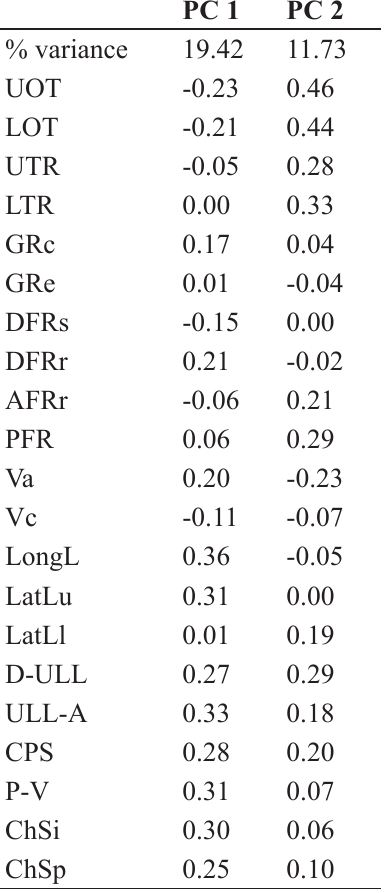
Table S7. PCA loadings of 21 counts from: H . latifrons sp. nov., H . mentatus , H . rex sp. nov., H . simba sp. nov., H . glaucus sp. nov., H . aquila sp. nov., H . kimondo sp. nov., H . falcatus sp. nov., H . curvidens sp. nov., H . pardus sp. nov., H . quasimodo sp. nov., and H . squamipinnis . Results illustrated in Fig.